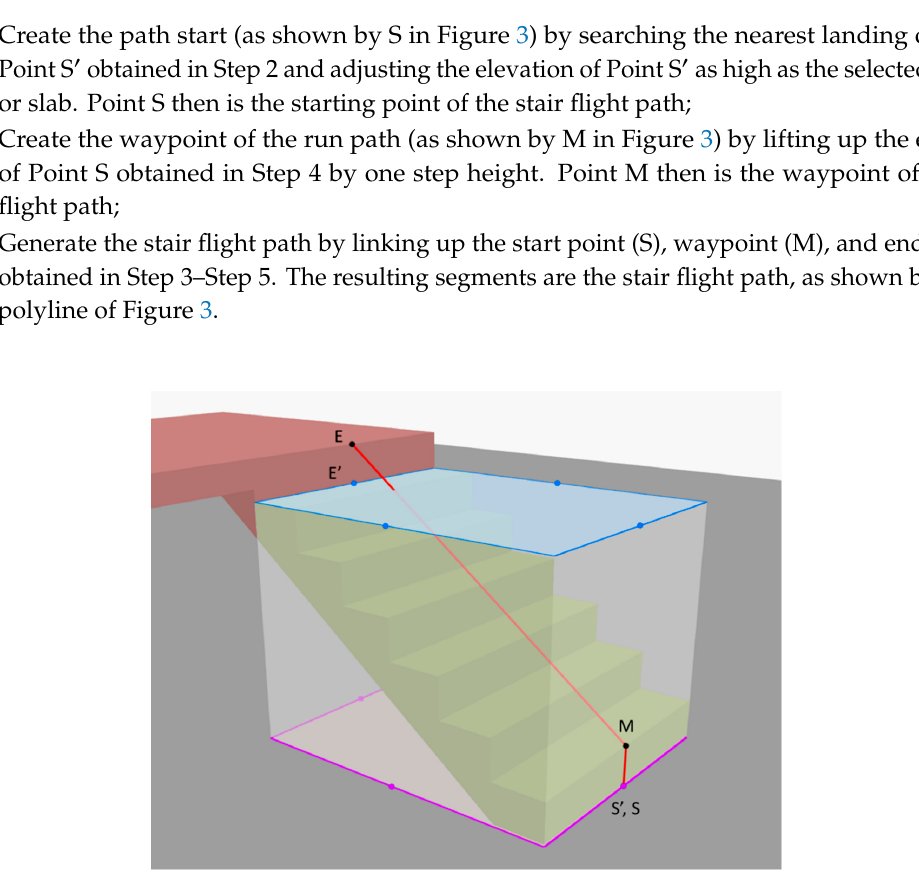
Figure 3. Illustration of stair flight path generation logic in the 2nd version of the intelligent generation of indoor topology (i-GIT) algorithm [33].